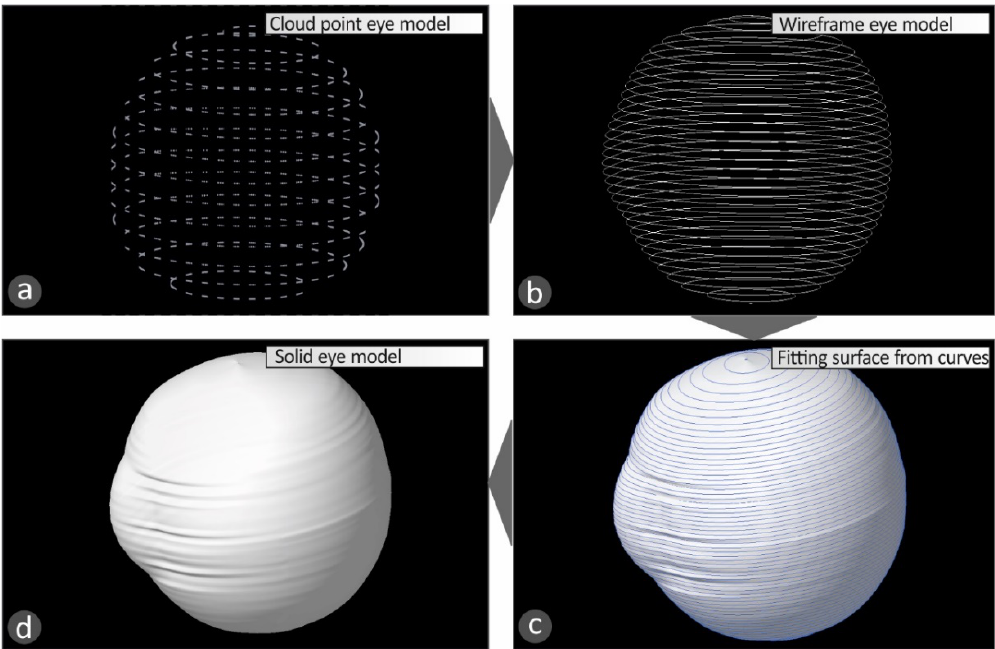
Figure 5. Steps for the development of the 3D geometric model of the patient’s eye using a CAD software tool: ( a ) cloud points, ( b ) planar 3D curves, ( c ) fitting 3D surface to the successive curves, ( d ) the final 3D geometric model of the patient’s eye.